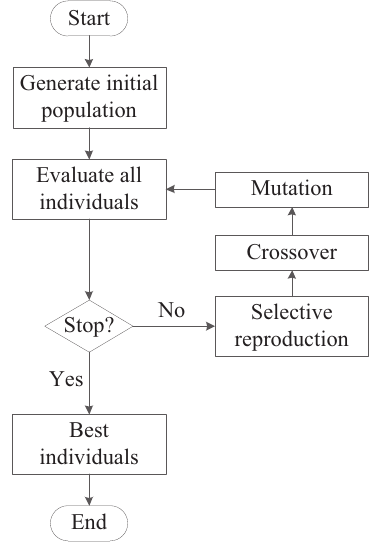
Figure 3. Diagram of the proposed method for the stiffness-oriented cable tension distribution problem of the